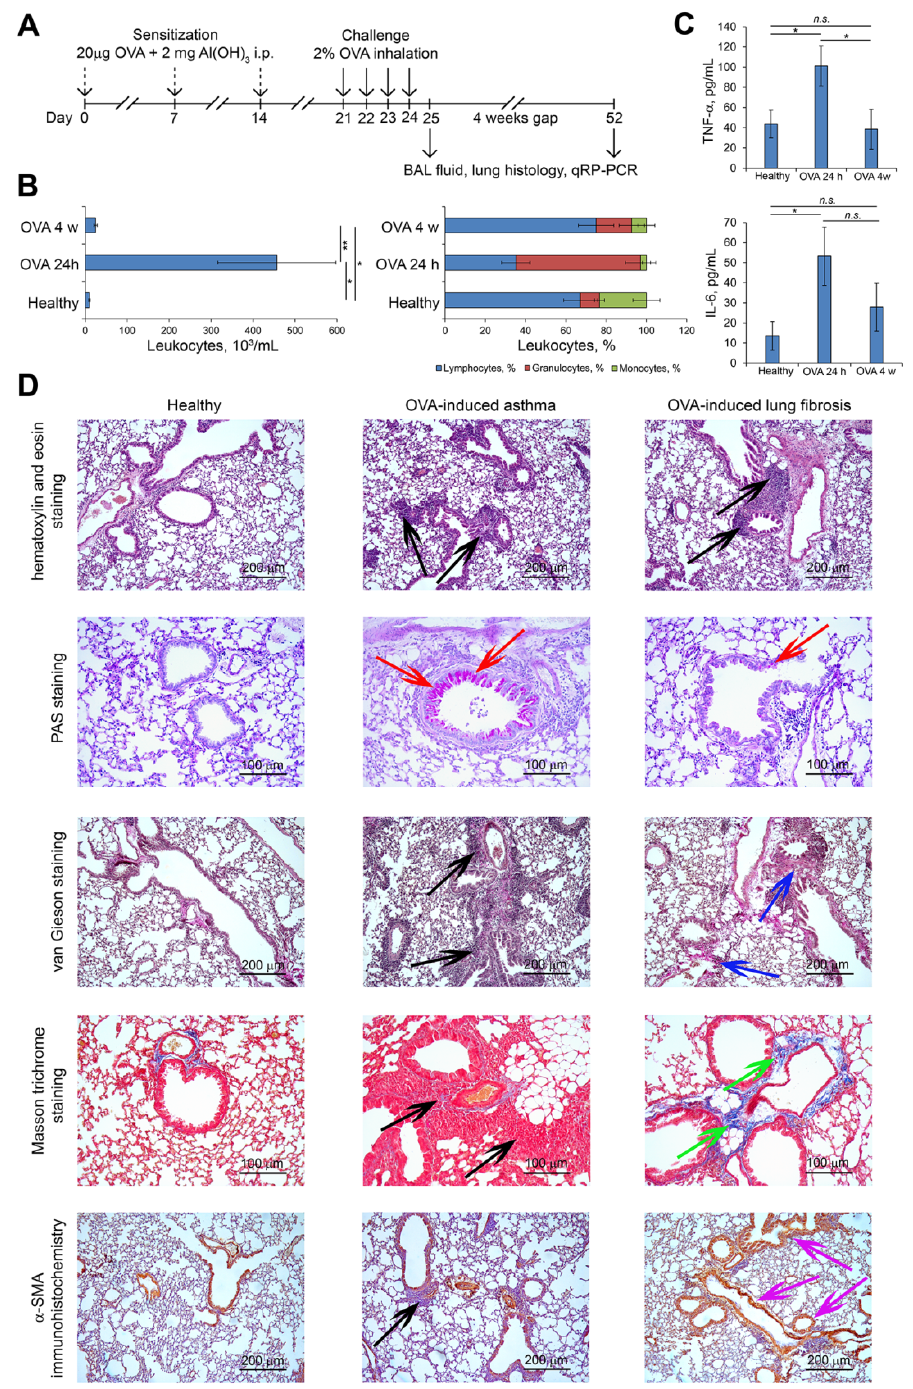
Figure 4. Ovalbumin (OVA)-induced murine model of asthma. ( A ) The experimental setup. BALB/c mice were sensitized by threefold intraperitoneal (i.p.) injection of 20 µ g OVA/2 mg aluminum hydroxide (Al(OH) 3 ) mixture and then challenged with aerosolized 2% OVA for four consecutive days. Samples for bronchoalveolar (BAL) fluid, histopathological, and qRT-PCR analysis were collected 24 h (day 25) and 4 weeks (day 52) after the last OVA challenge. ( B ) Total (left) and differential (right) leukocyte counts in the BAL fluid of healthy and OVA-challenged mice 24 h and 4 weeks after induction. Total leukocyte counts were estimated using Neubauer chamber. The distribution of leukocyte subpopulations was measured by light microscopy after Romanowsky–Giemsa staining. ( C ) The levels of pro-inflammatory cytokines TNF- α (upper panel) and IL-6 (bottom panel) in BAL fluid measured by ELISA. The data are shown as mean ± standard deviation. The statistical analysis was performed using the two-tailed unpaired t -test; * p ≤ 0.05, ** p ≤ 0.01, n.s., not significant. ( D ) Representative histological images of lung sections of